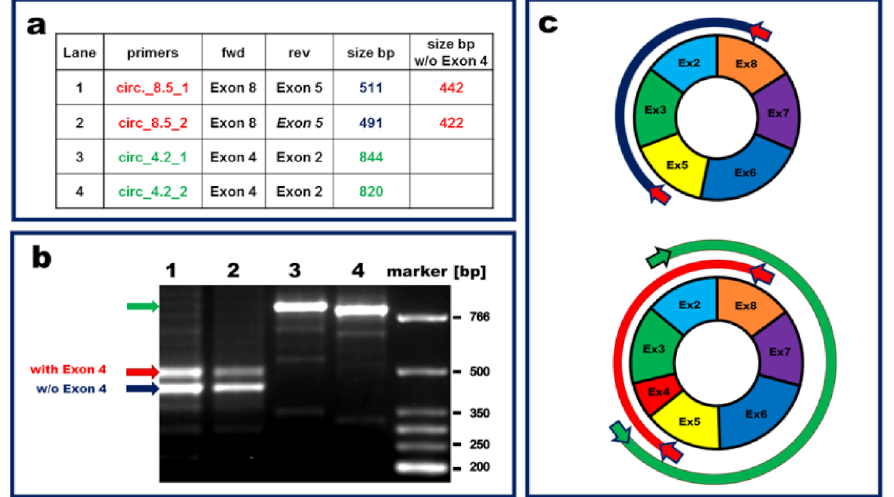
Figure 3. Characterization of circANKRD12 in human endothelial cells. Sanger sequencing was performed to explore the structure of circANKRD12 expressed in HUVEC. ( a ) Table showing details of divergent primer pairs designed to exclusively amplify circular transcripts sharing the back-splice junction between exon 2 and exon 8. ( b ) Agarose gel analysis performed with amplicons obtained by RT-PCR. Arrows indicate the bands extracted for sequencing. ( c ) Two circular isoforms of ANKRD12 as identified by Sanger sequencing. The blue band represents the sequenced amplicons derived from the circular transcript lacking exon 4. The green and red bands represent sequences derived from the transcript comprising exon 4. Arrows depict the primes used for